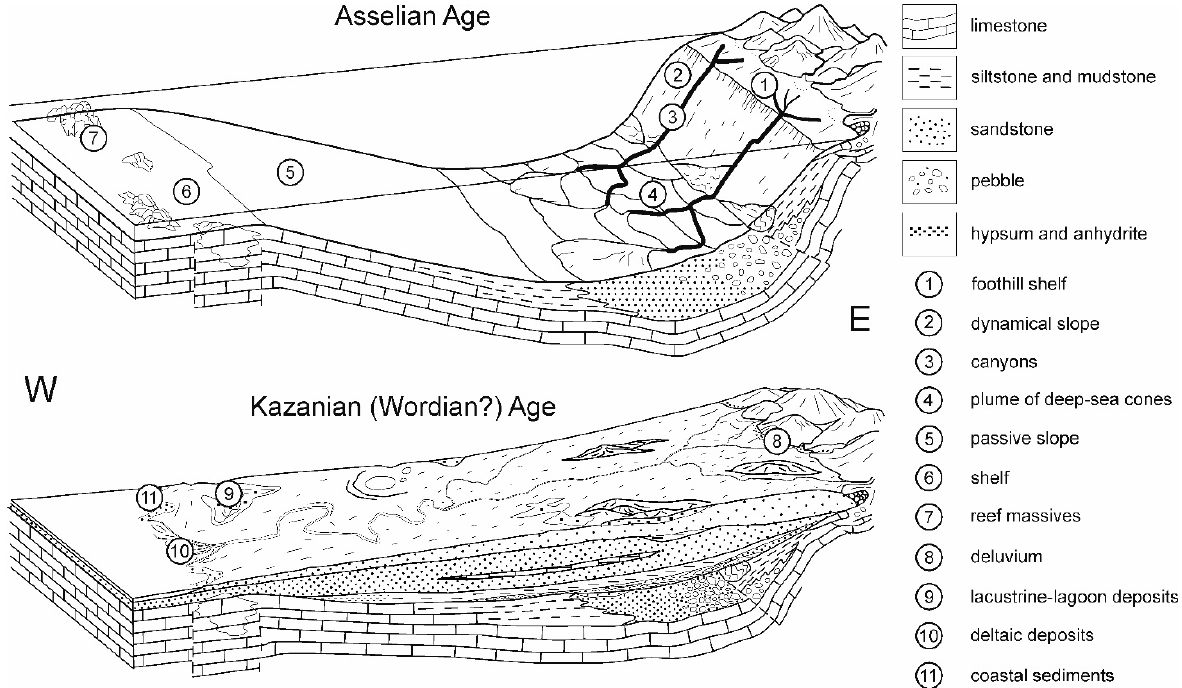
Figure 16. A simplified cross-section of the Ural Foredeep for the Early Permian ( top ) and Middle Permian time ( bottom ), modified after Mizens [50].